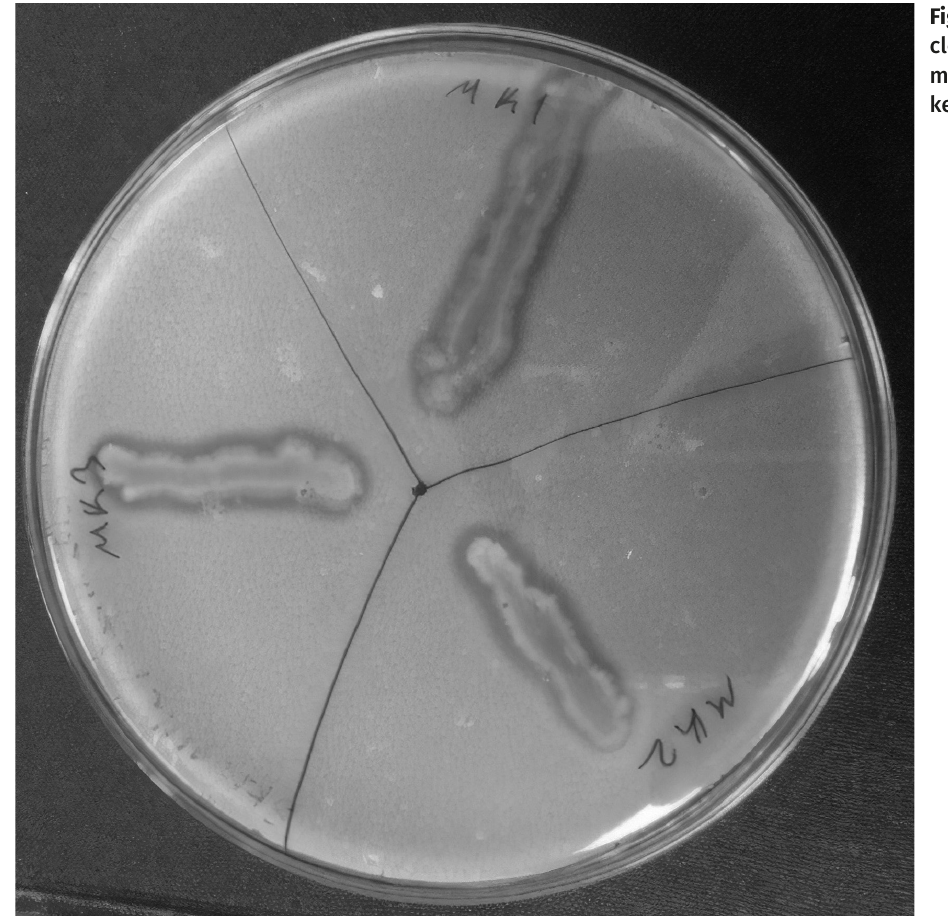
Figure 1. Production of clear zones in feather– meal agar plates using keratinolytic